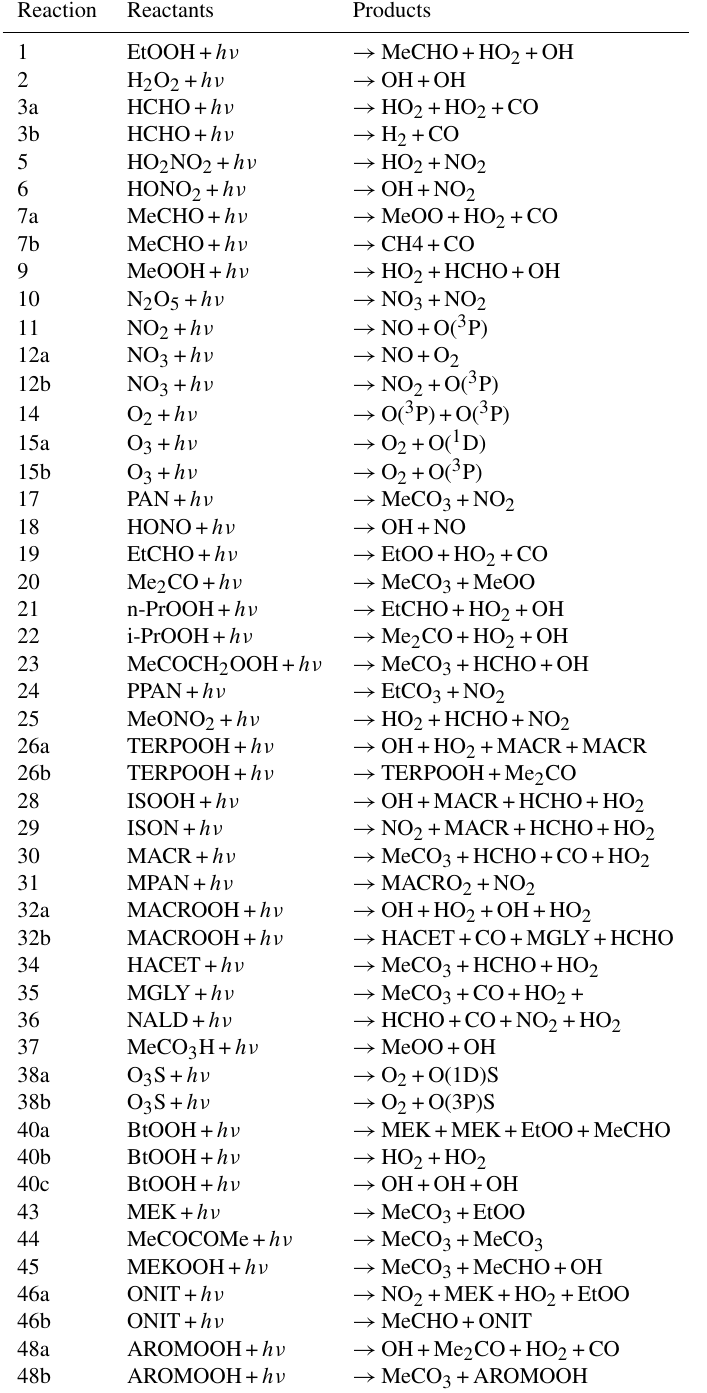
Table 5. TOMCAT photolysis